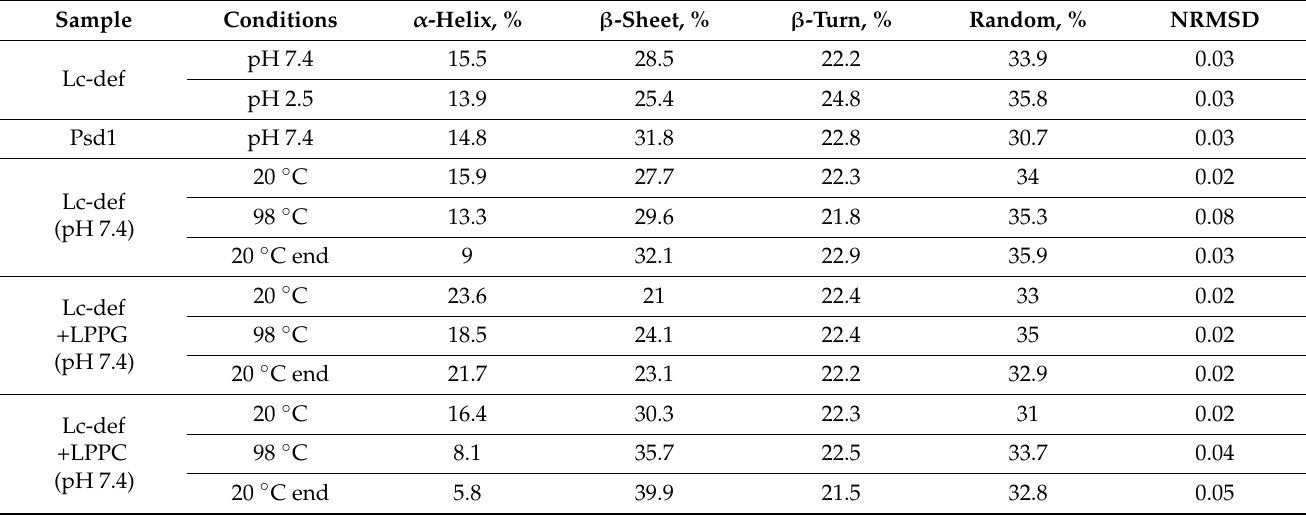
Table 1. Secondary structure estimation (%) predicted from far-UV CD spectra.